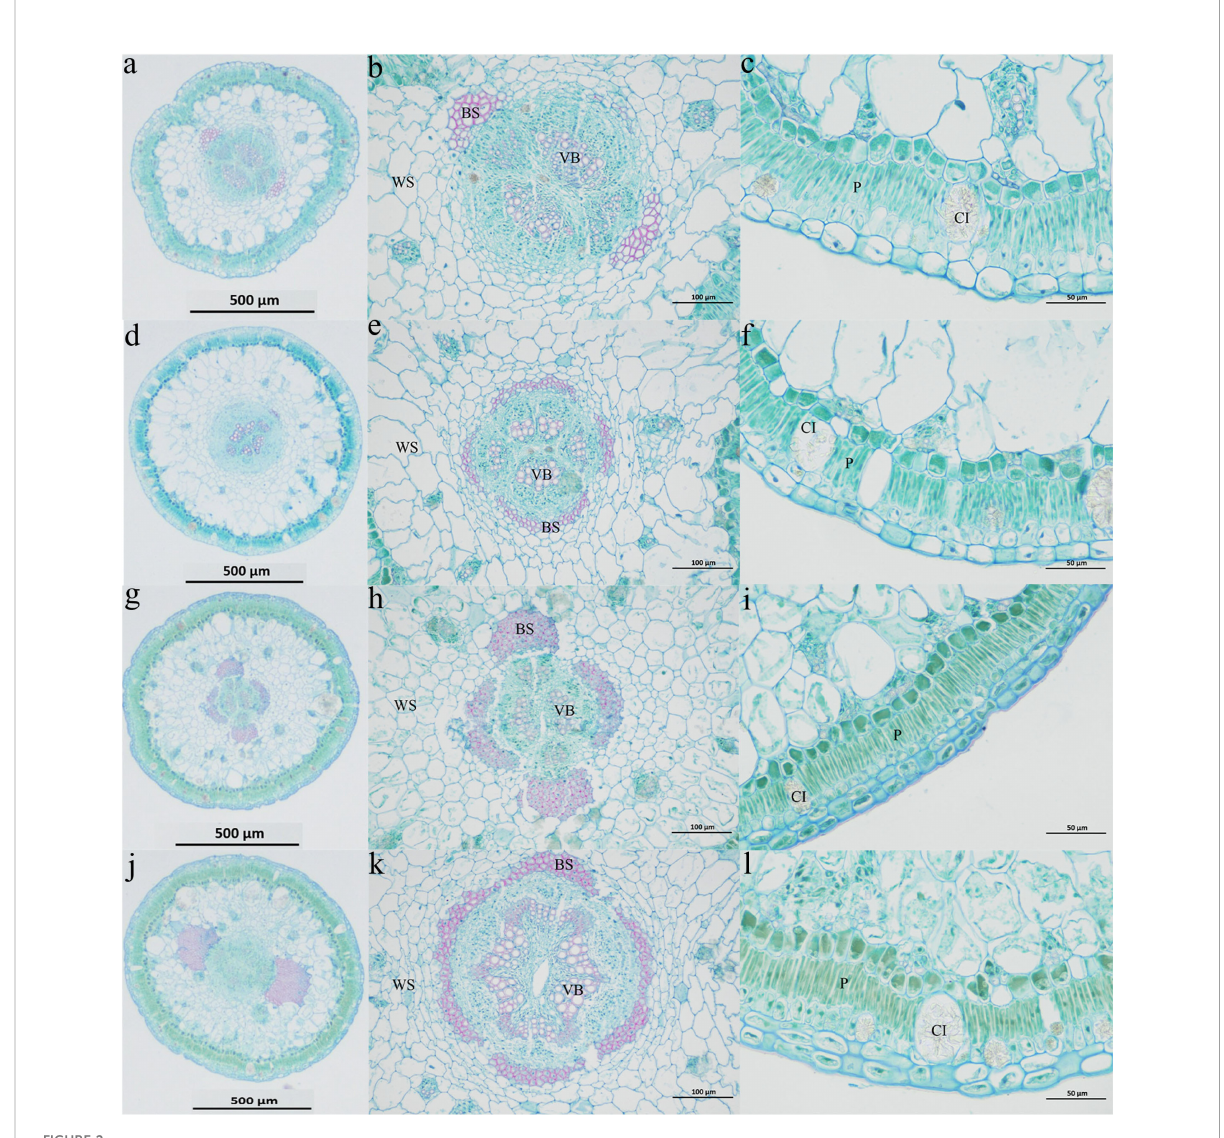
FIGURE 2 Cross-section anatomy of the assimilatory branches of H. ammodendron and H. persicum . (A – C) represent the cross sections (HS) of H. ammodendron in a moist soil environment. (D – F) represent the cross-sections (LS) of H. ammodendron in an arid soil environment. (G – I) represent the cross-sections (HB) of H. persicum in the moist soil environment. (J – L) represent the cross-sections (LB) of H. persicum in an arid soil environment. BS: Vascular bundle sheath cells; CI: Crystalline cells; P: Palisade tissue; VB: Vascular bundle; WS: Aqueous